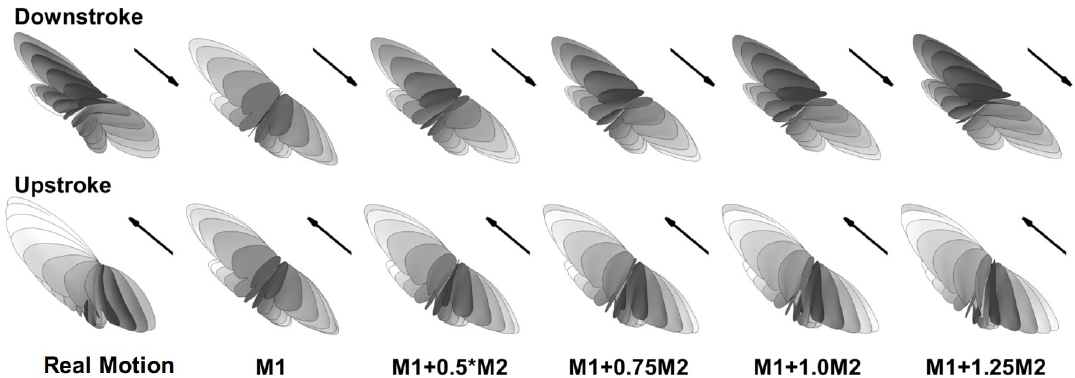
Figure 2. Wing trajectory for the real and synthetic kinematics during downstroke ( top row ) and upstroke ( bottom row ) with evenly spaced snapshots in time. M1 = principle mode 1. M2 = principle mode 2.